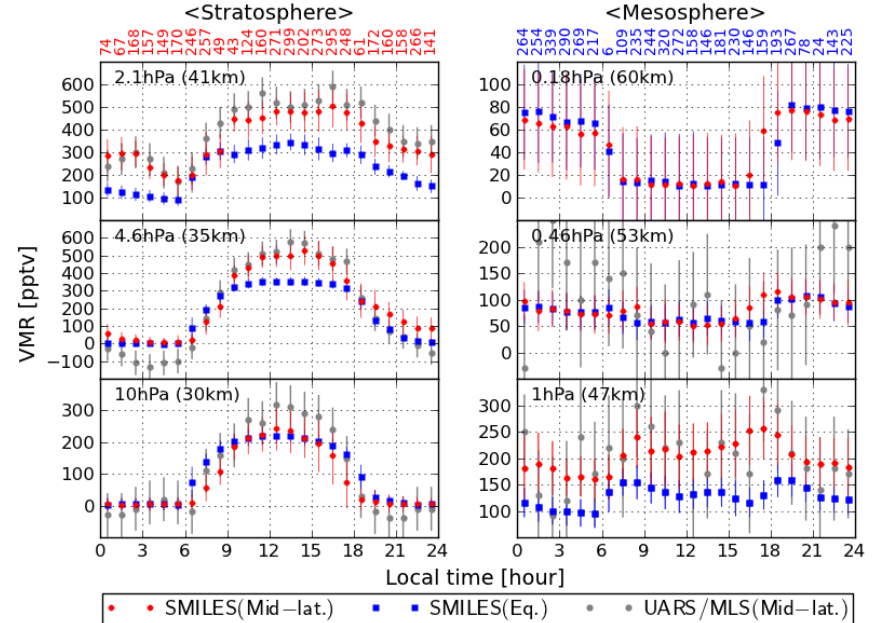
Fig. 10. ClO diurnal variations observed by SMILES and UARS/MLS at pressures of 0.18, 0.46, 1, 2.1, 4.6 and 10hPa for zonal mean. Red: SMILES at 40 ◦ N–50 ◦ N. Blue: SMILES at 5 ◦ S–5 ◦ N. Gray: UARS/MLS at 40 ◦ N–50 ◦ N. The data are averaged within a local time bin of 1-h intervals. The vertical error bars represent 1- σ standard deviations. The numbers of profiles averaged at each local time for the SMILES observations at 40 ◦ N–50 ◦ N and 5 ◦ S–5 ◦ N are indicated at the top of the left and right panels, respectively. The vertical grids for SMILES were adjusted to the UARS/MLS grids with linear interpolation. The SMILES data are taken for the observation period from January to February 2010, while UARS/MLS data are taken by averaging February data for the seven years from 1991 to 1997. The UARS/MLS data are taken from Fig. 1 in Ricaud et al. (2000). Arbitrary offsets are respectively added to the UARS/MLS data of 100, 200, 400, 200 and 100pptv at 0.46, 1, 2.1, 4.6 and 10hPa, since the UARS/MLS data have a negative bias. 2.1, 4.6 and 10 hPa to the UARS/MLS ClO observations. The vertical error bars represent 1- σ standard deviations for both SMILES and UARS/MLS. The nighttime ClO VMR values are near zero from 00:00– 06:00 (a.m.) in the middle stratosphere at 10 hPa (30 km) and 4.6 hPa (35 km). The standard deviations in these time and pressure region present an internal error in the SMILES ClO observations, and not natural variations. The standard devi- ations are about 20–30 pptv and consistent with the random error of 30 pptv estimated by the error analysis. This indi- cates that the error analysis results are